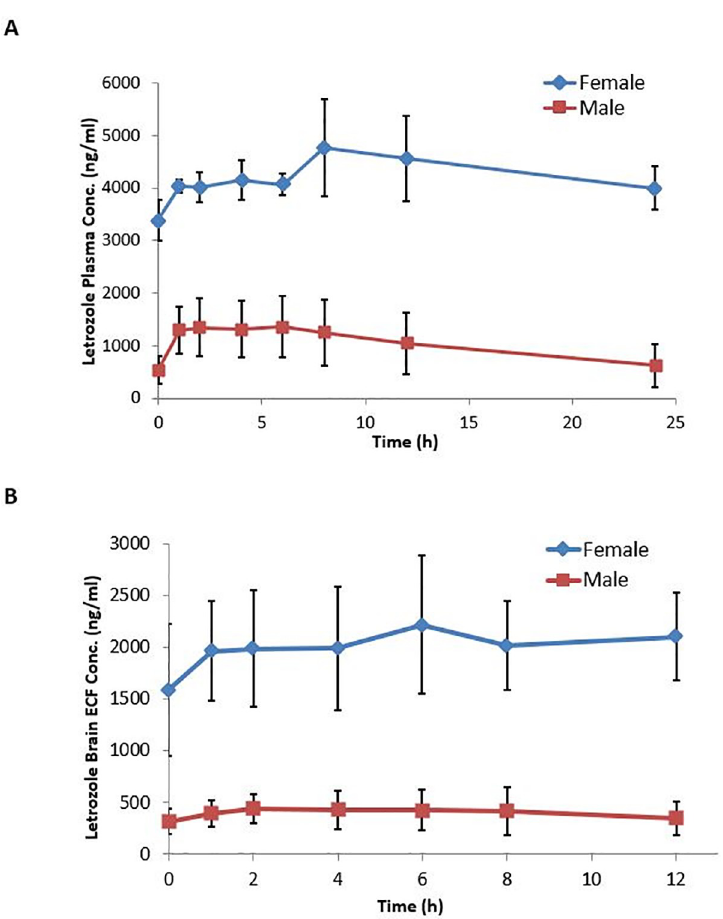
Fig 3. Steady state plasma and brain ECF pharmacokinetics of letrozole in male and female Sprague- Dawley rats. Letrozole (4 mg/kg) was given once daily for 5 or 11 days to male and female rats respectively to establish steady state. A) Plasma samples were collected via the jugular vein catheters up to 24 hours following drug administration. B) Simultaneous microdialysate sample collection was carried out from 0–12 hours. Dialysate concentrations were corrected for in vitro recovery of 7.2%. Concentration–time plots were obtained and the data were presented as mean ± SD (N = 4–6 rats/group); mean concentrations of letrozole in females ( ♦ ) and males ( ■ ).